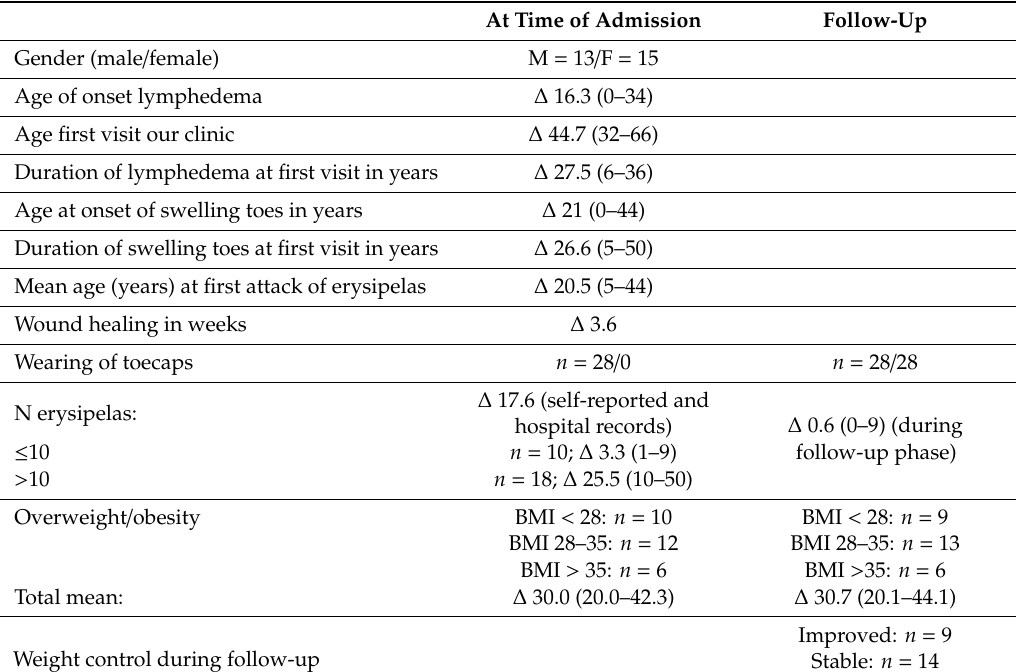
Table 2. Clinical data and results of 28 patients who underwent surgical treatment for elephantiasis nostras